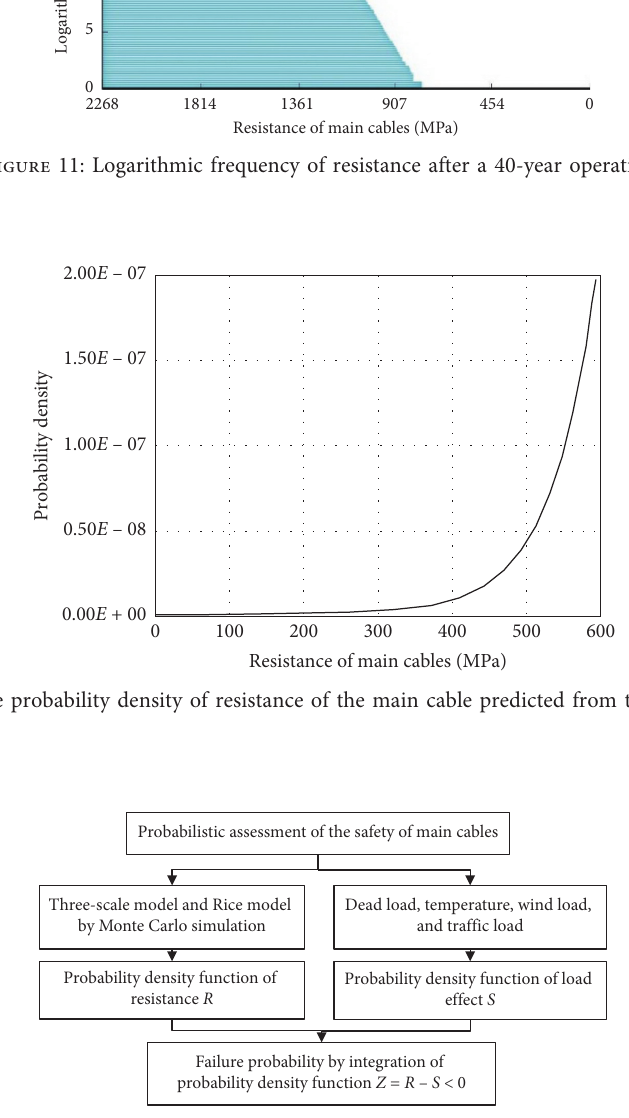
Figure 13: Flowchart of the assessment of the safety of main